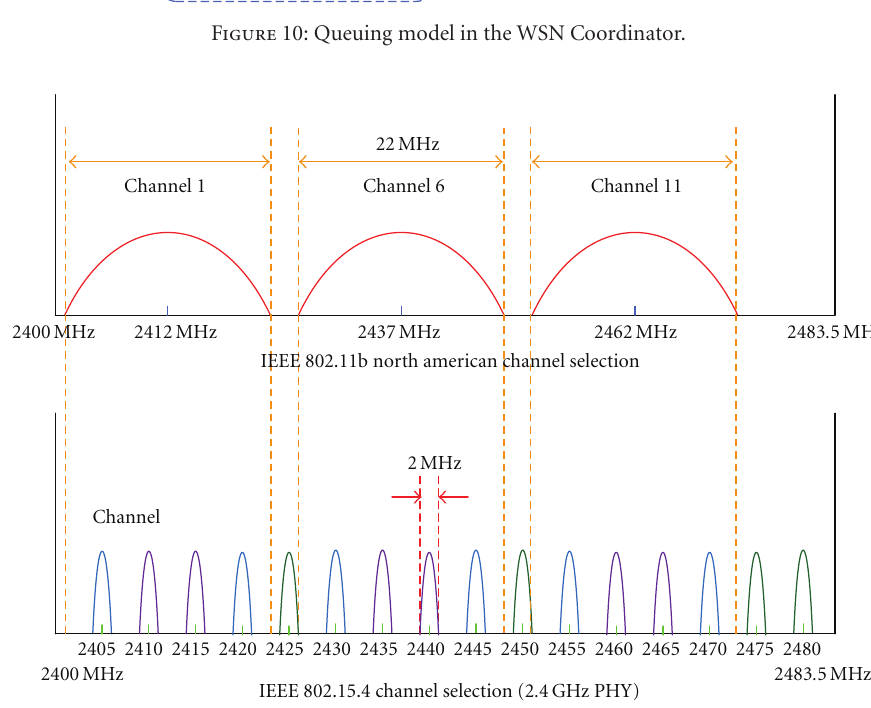
Figure 11: Zigbee and Wi-Fi channels in the 2.4GHz